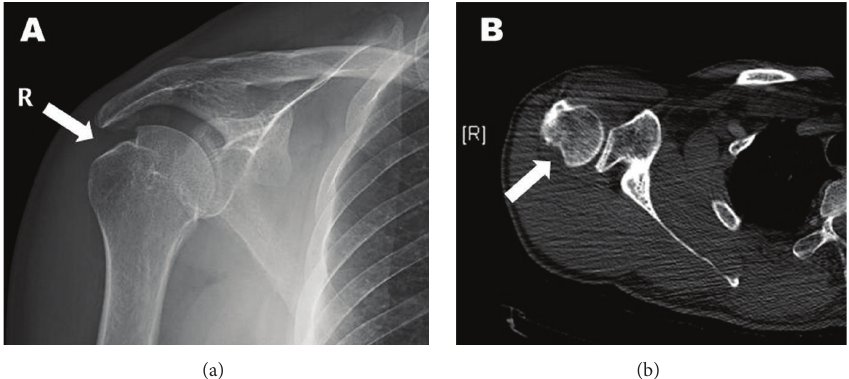
Figure 1: Preoperative imaging of the right shoulder. A medium size Hill-Sachs lesion is demonstrated in the posterosuperior aspect of the humeral head (arrow) in a plain AP radiograph of the shoulder (a) and in an axial plain image of a CT scan (b), suggesting previous anterior dislocation of the glenohumeral joint.